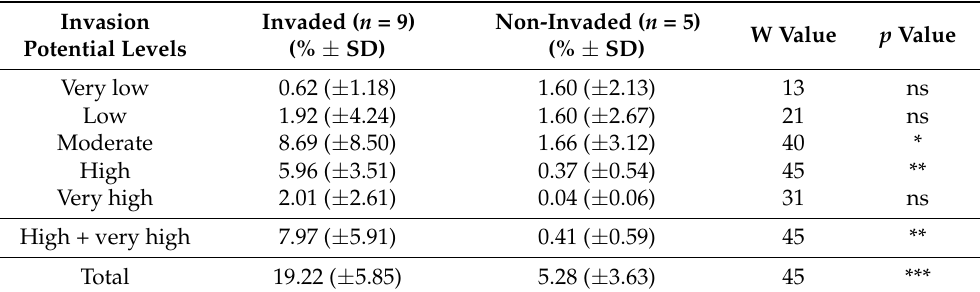
Table 6. Average percentage of different levels of invasion potential inside 14 Natura 2000 sites, classified as invaded or non-invaded by [40], and comparison between the two groups using Mann–Whitney